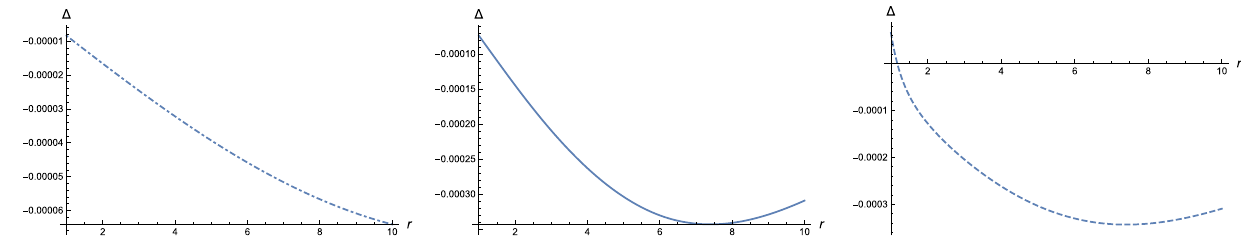
Fig. 15 Variations of anisotropic measure (cid:19) with respect to the radial coordinate r (km) of the strange star candidate Her X-1, SAX J 1808.4-3658, and 4U 1820-30; represented by (left to right) the first, second, and third graphs,